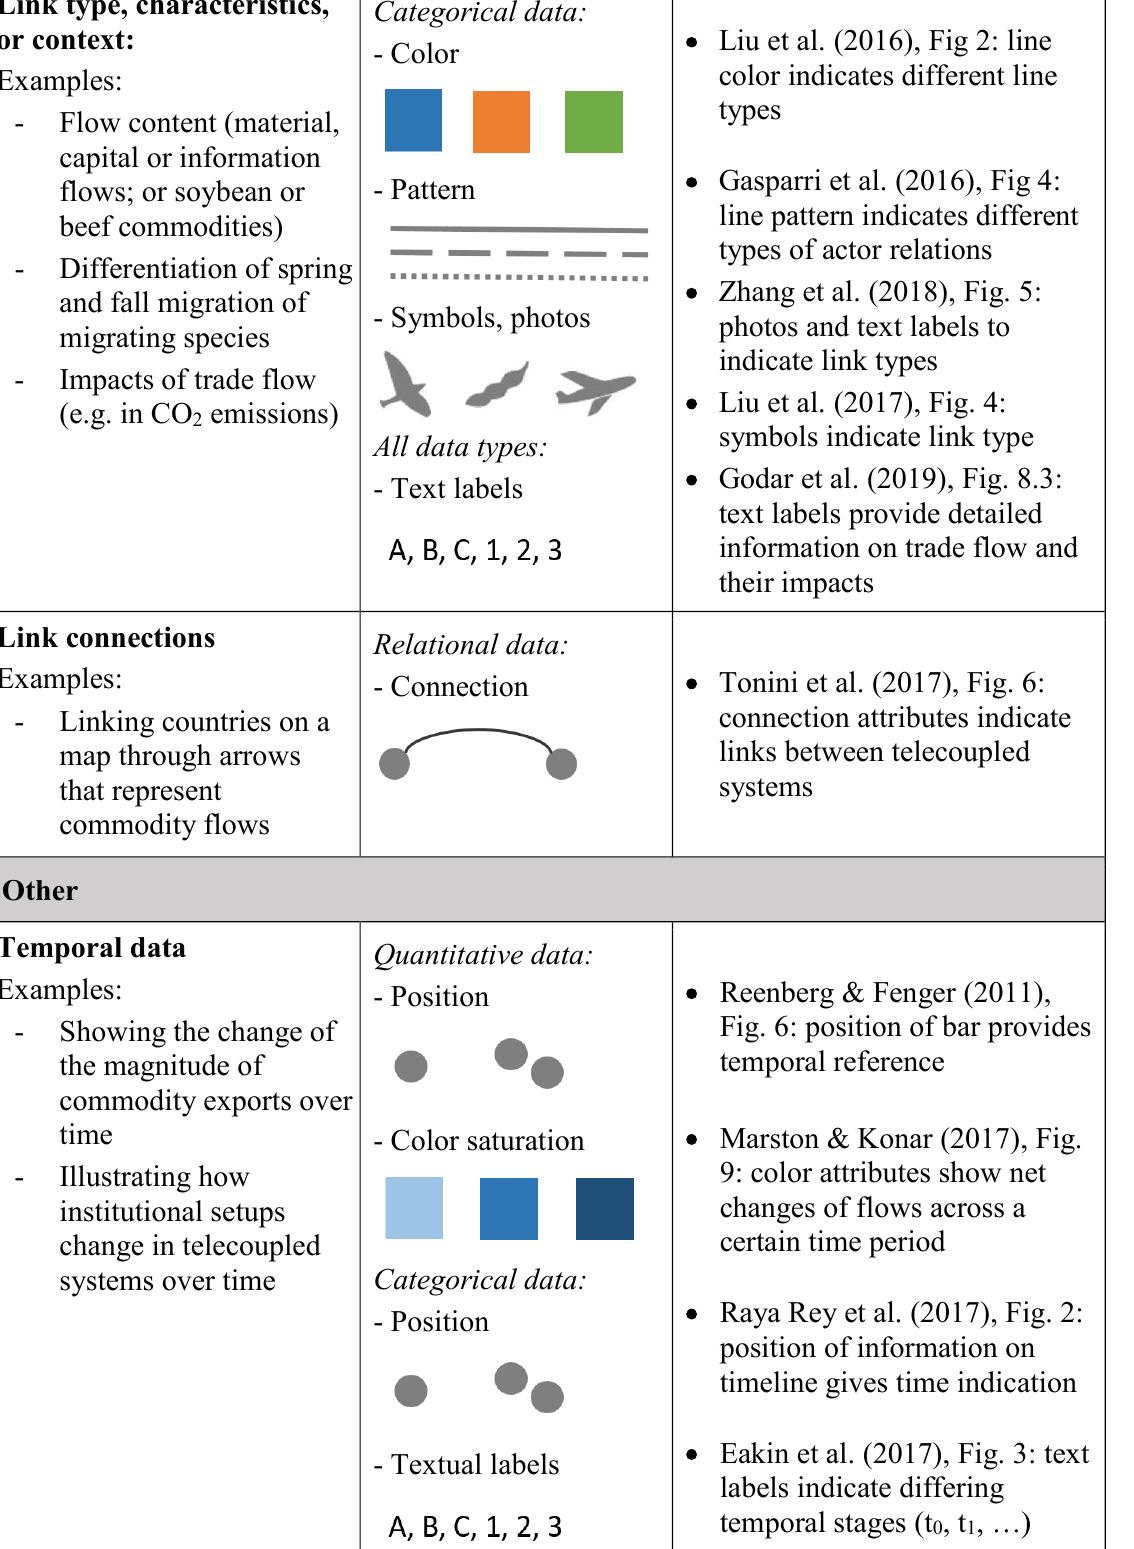
Fig. 6: position of bar provides temporal reference Marston & Konar (2017), Fig. 9: color attributes show net